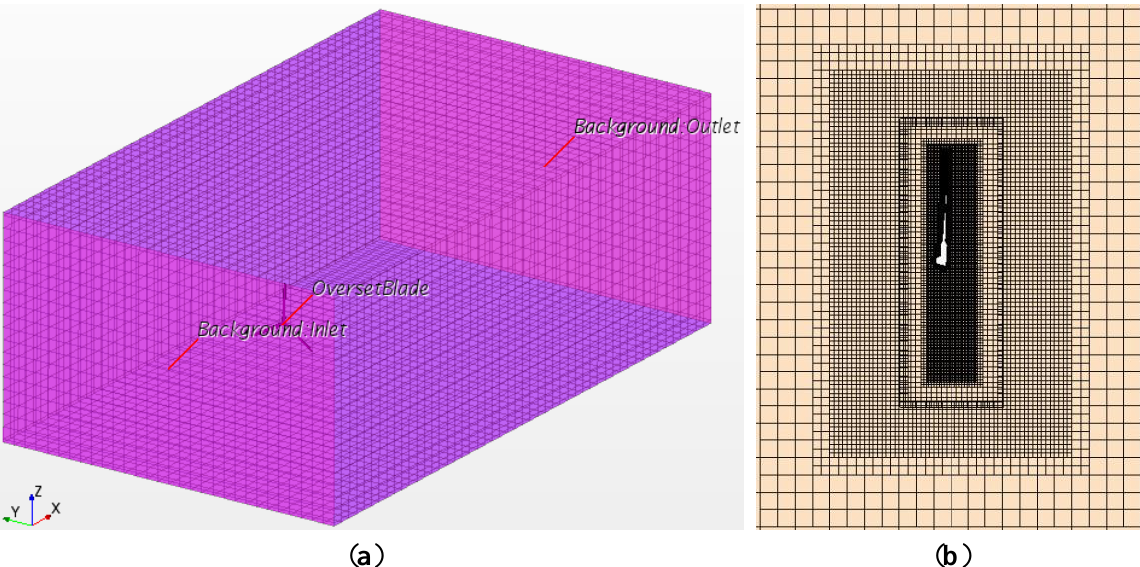
Figure 3. ( a ) Illustration of the computational mesh domain; ( b ) Zoon-in refine overset grid area; ( c ) A view of layer grid adjustment blade surface; and ( d ) Blade surface tip